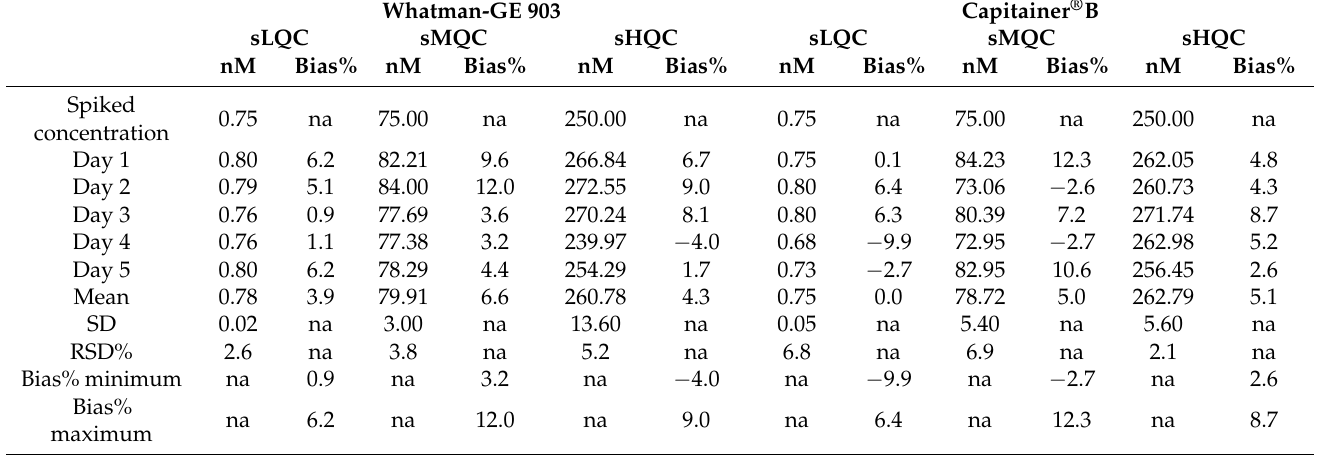
Table 3. Inter-day ( n = 5) assays performed with spiked quality control (sQC) dried blood spots (DBSs) prepared at three concentration levels by spiking lyso-Gb 3 - 13 C 6 in a pool of blood from control